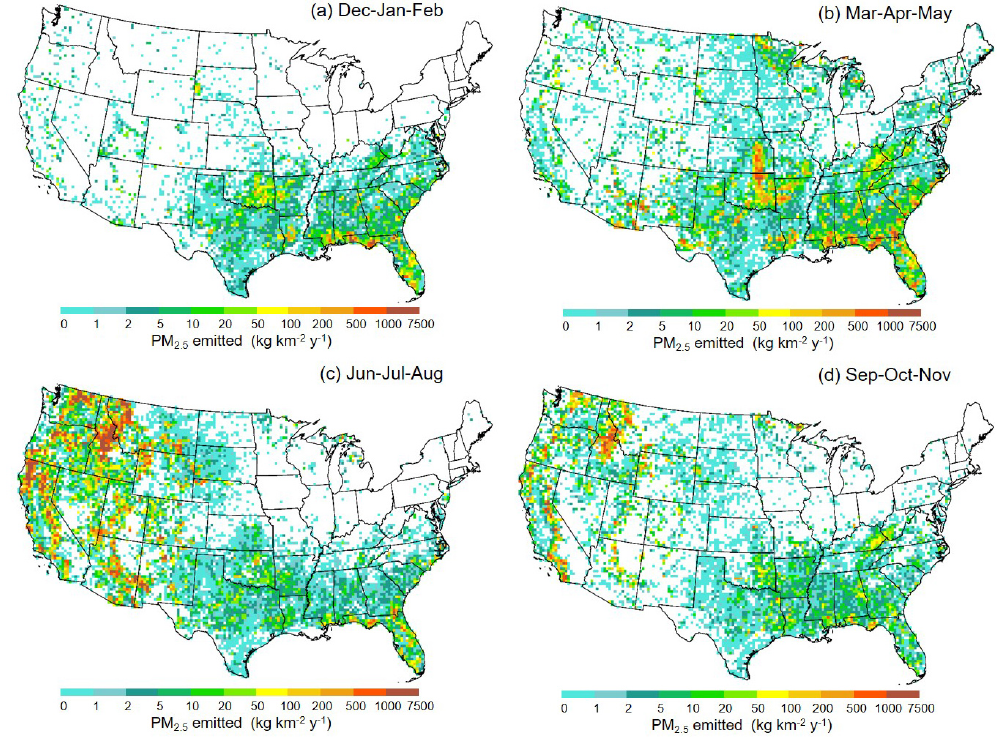
Figure 13. Seasonal PM 2 . 5 emitted average over 2003–2015.